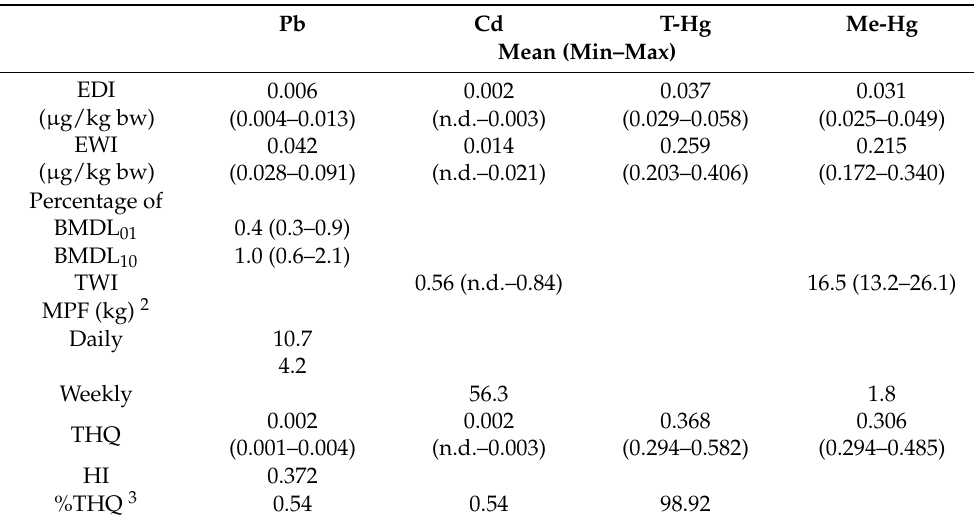
Table 4. Potential human health risk assessment for adults 1